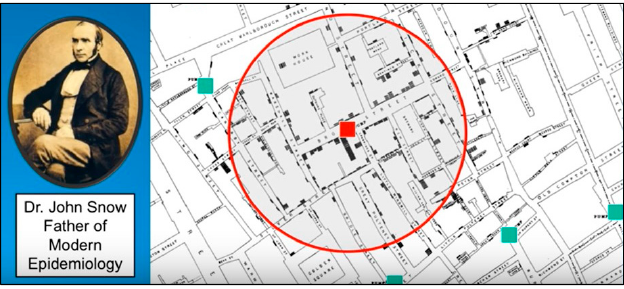
Figure 4. Spatial distribution of cholera cases in London, England, produced by Dr. Snow, 1854.(Source: [1]).